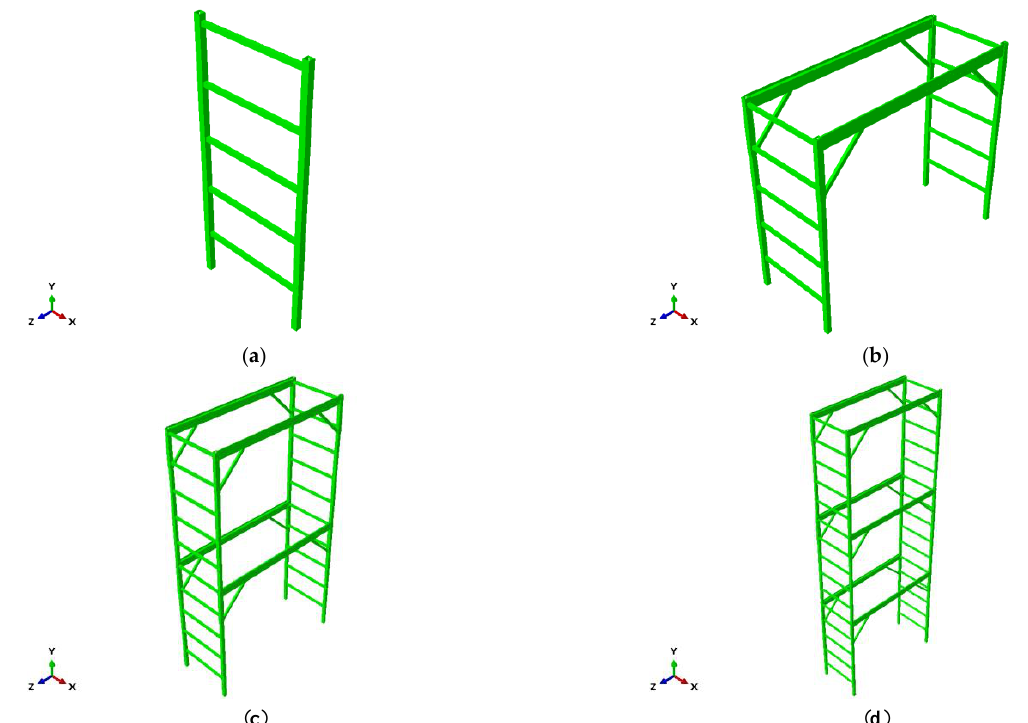
Figure 3. Structural analysis models of fabricated mobile scaffolds and mainframe. ( a ) Mainframe. ( b ) Single-story. ( c ) Two-story. ( d ) Three-story.